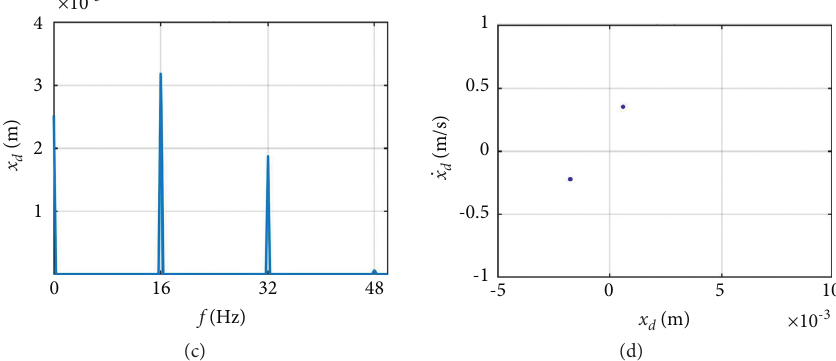
� 75 ) MN/m: (a) time history, (b) phase diagram, (c) frequency spectrum, and (d) s